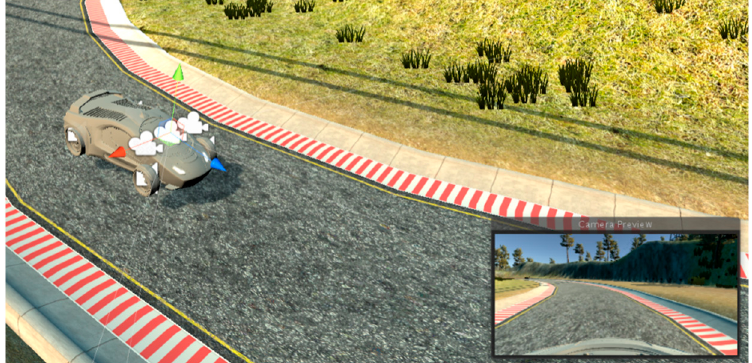
Figure 7. The vehicle in the simulator on the representative track, with three cameras on top of the vehicle. In right bottom corner is the view from the central camera at this particular moment.